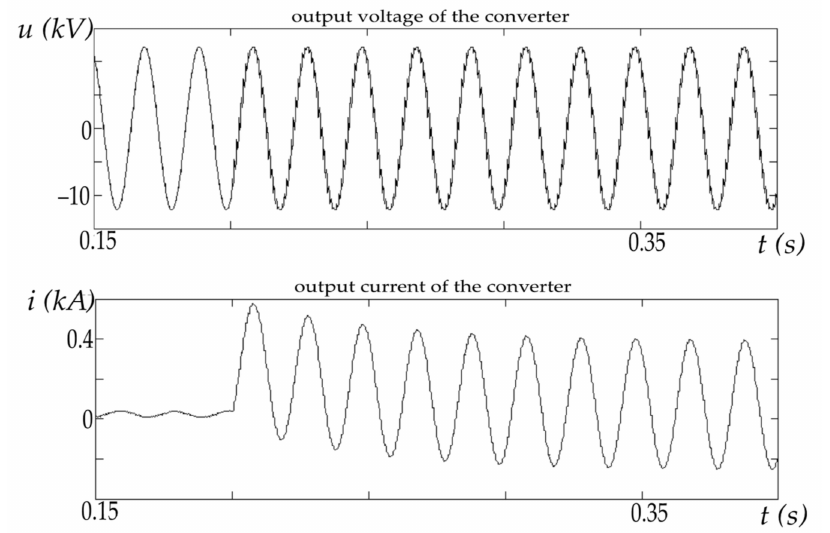
Figure 20. Output voltage and current of the 12 × 12 MC working between power systems for the “as close as possible” approach and for a 12 ◦ phase shift applied at 0.2 s of the